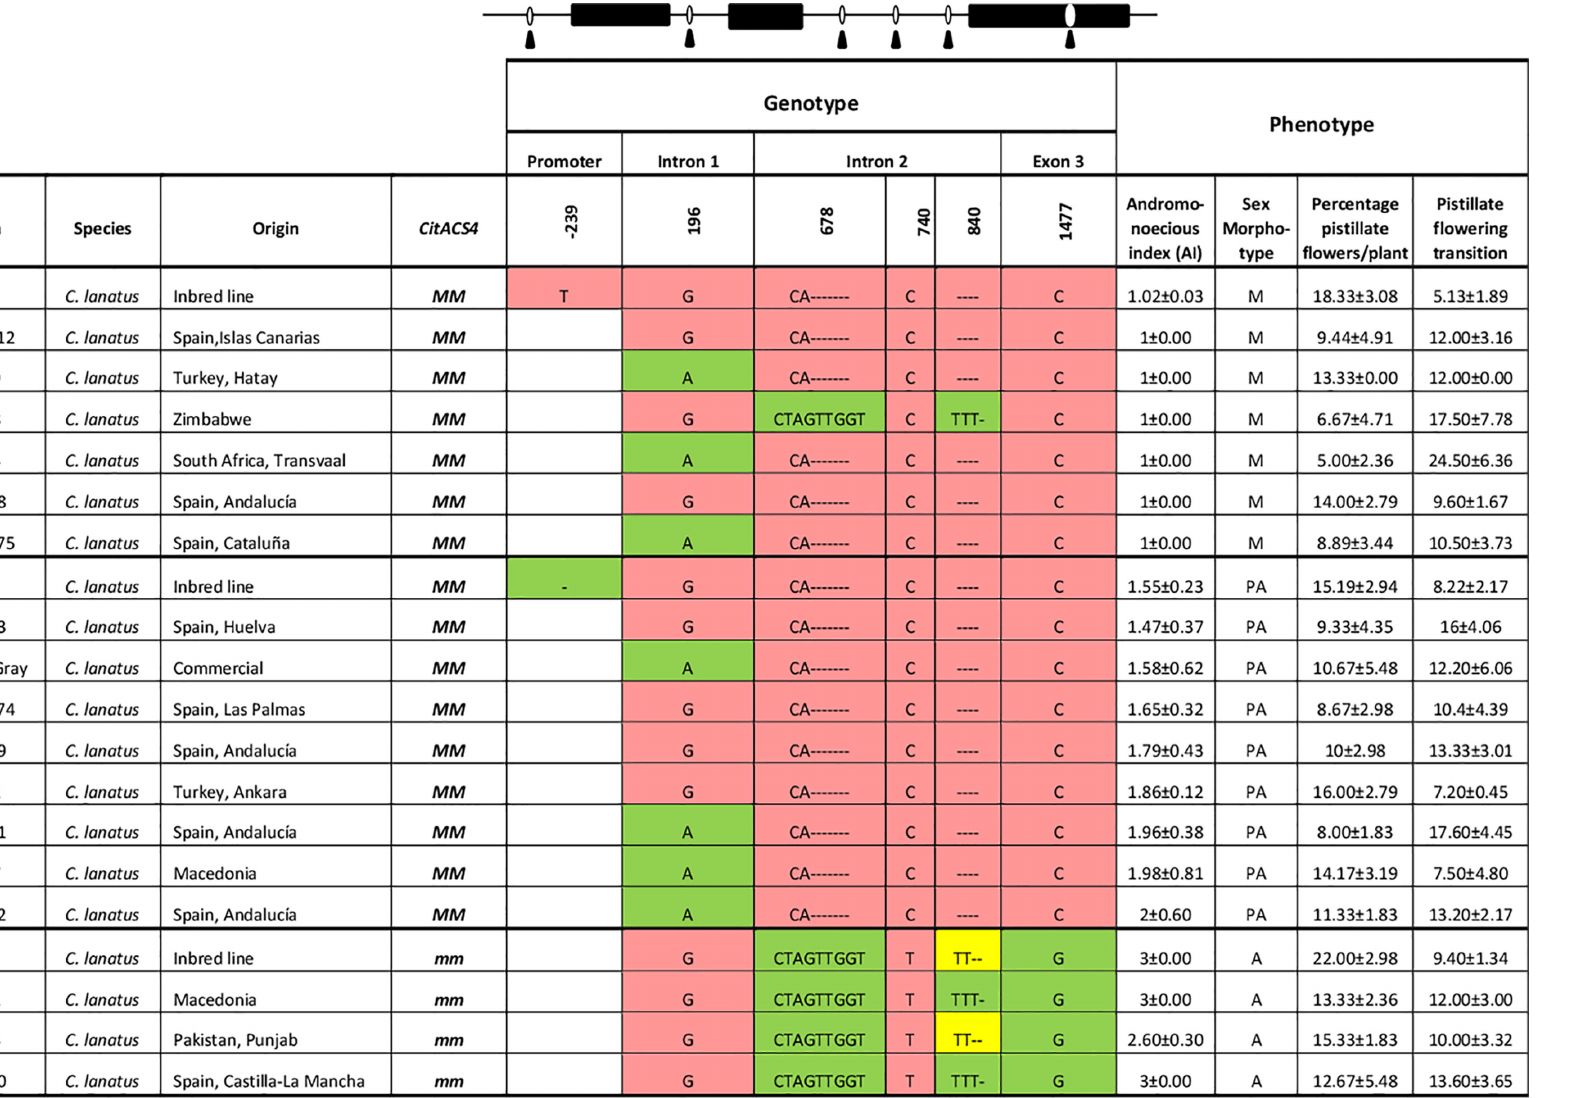
TABLE 1 | Polymorphic sites of CitACS4 gene in 20 watermelon accessions.